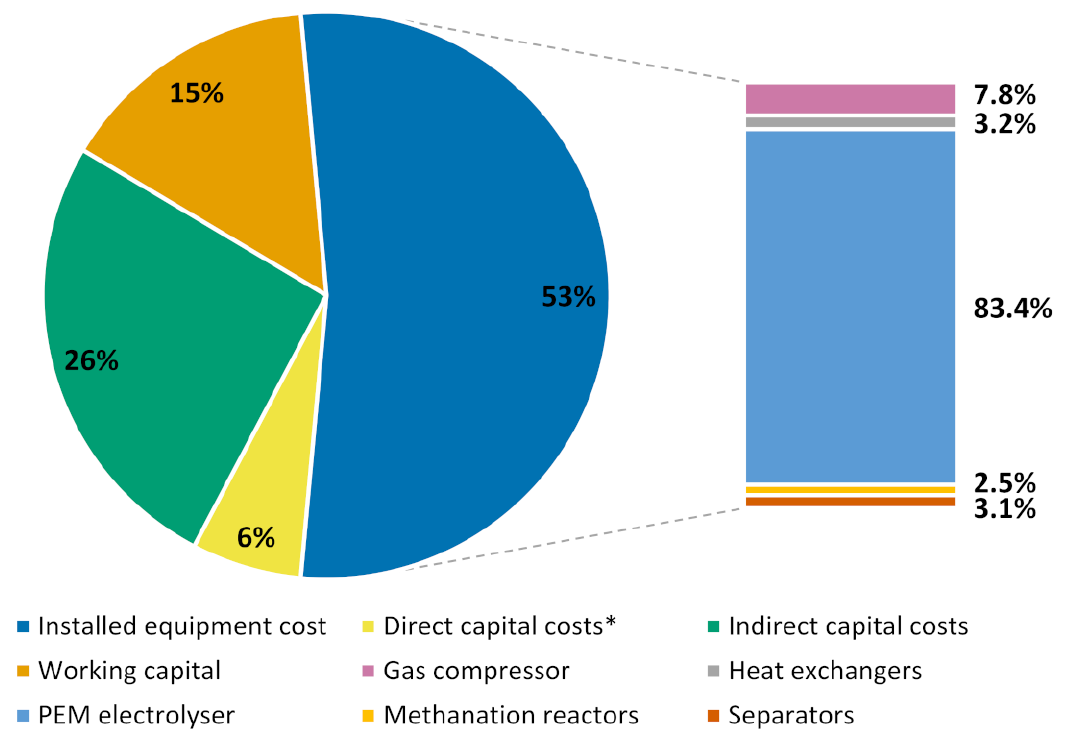
Figure 5. Total capital investment distribution for a 1 MW PtSNG plant. Installed equipment